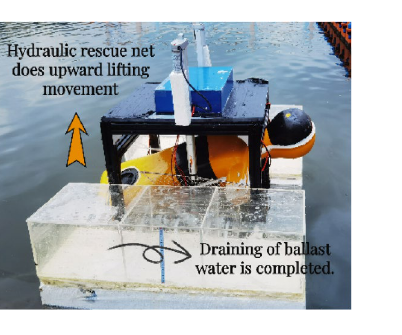
Figure 10. Experimental procedure